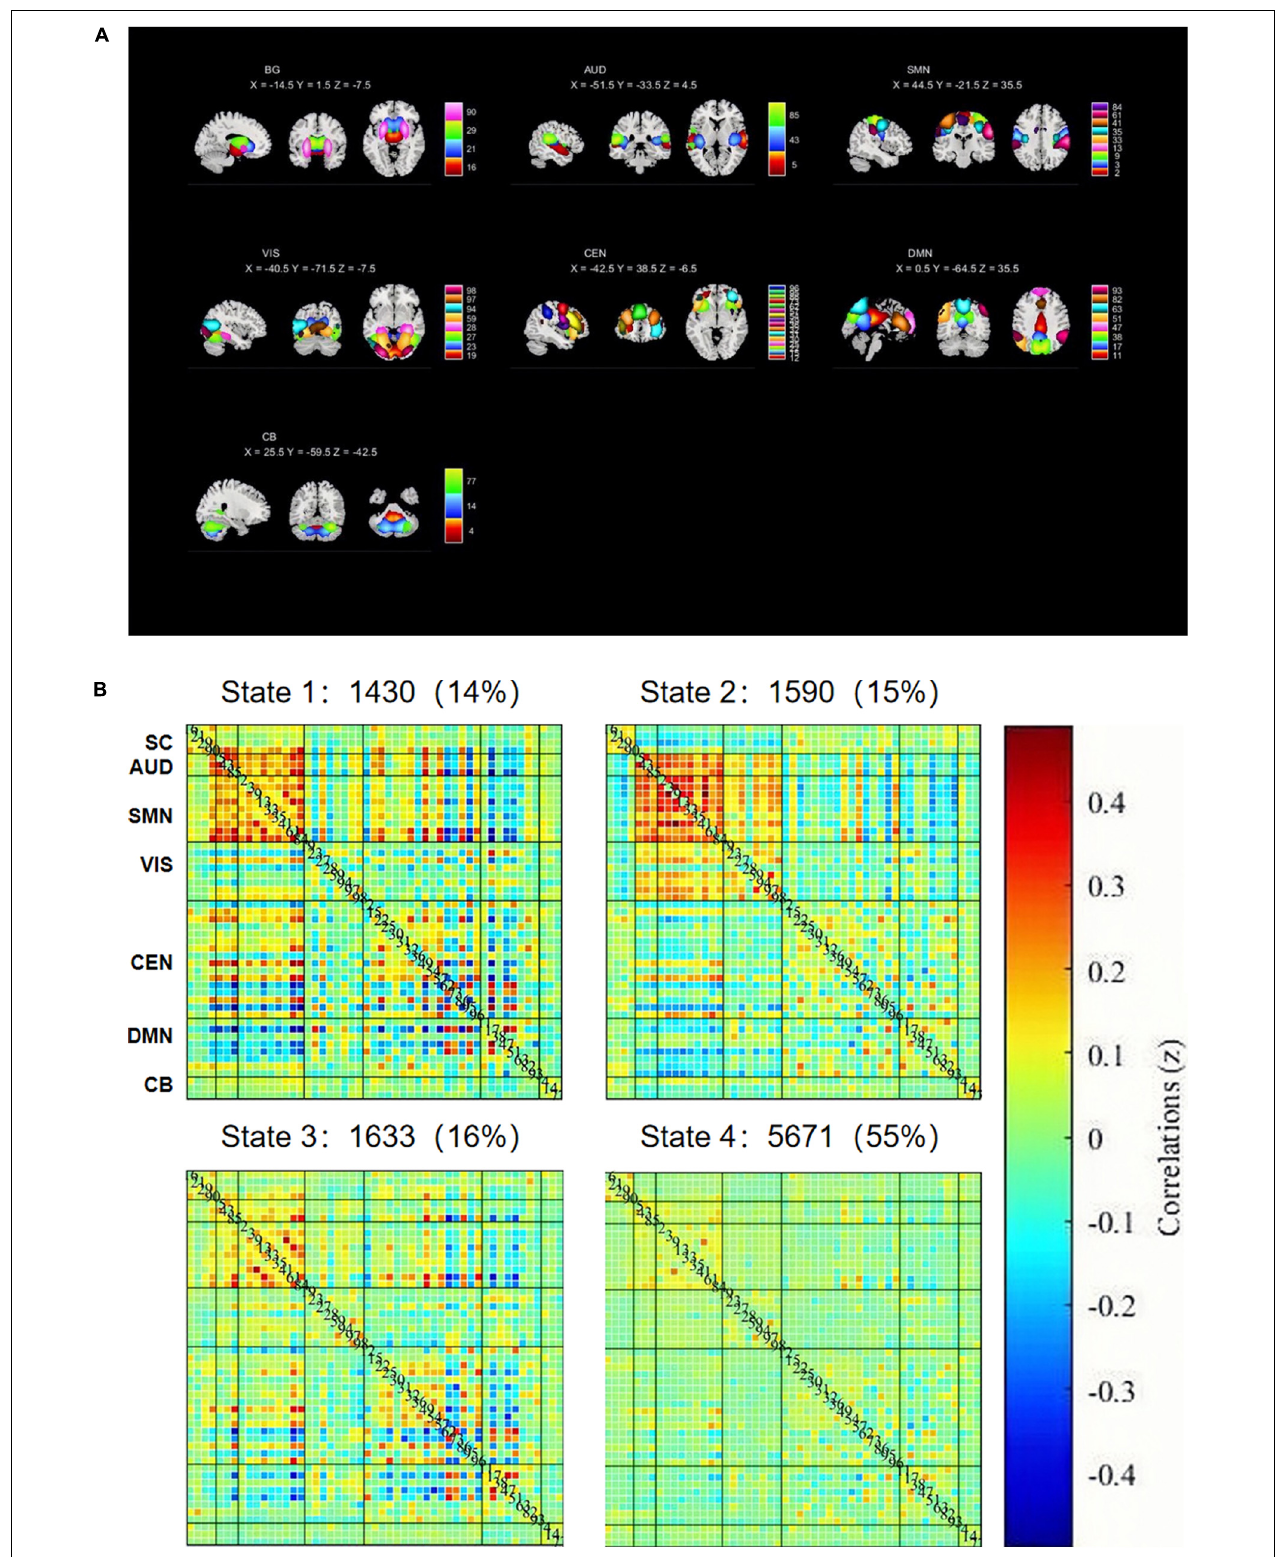
FIGURE 1 | (A) Basal ganglia (BG), auditory (AUD), sensorimotor (SMN), visual (VIS), default mode (DMN), cognitive executive (CEN), and cerebellar networks (CB). (B) The centroid of each FNC state and its total number (percentage) of occurrence in each state.